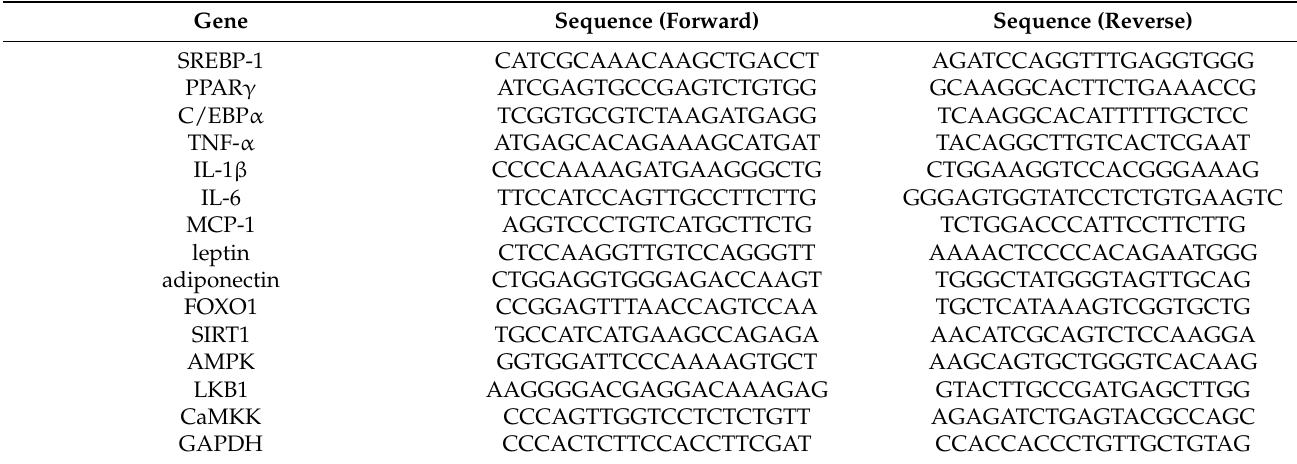
Table 1. List of primer